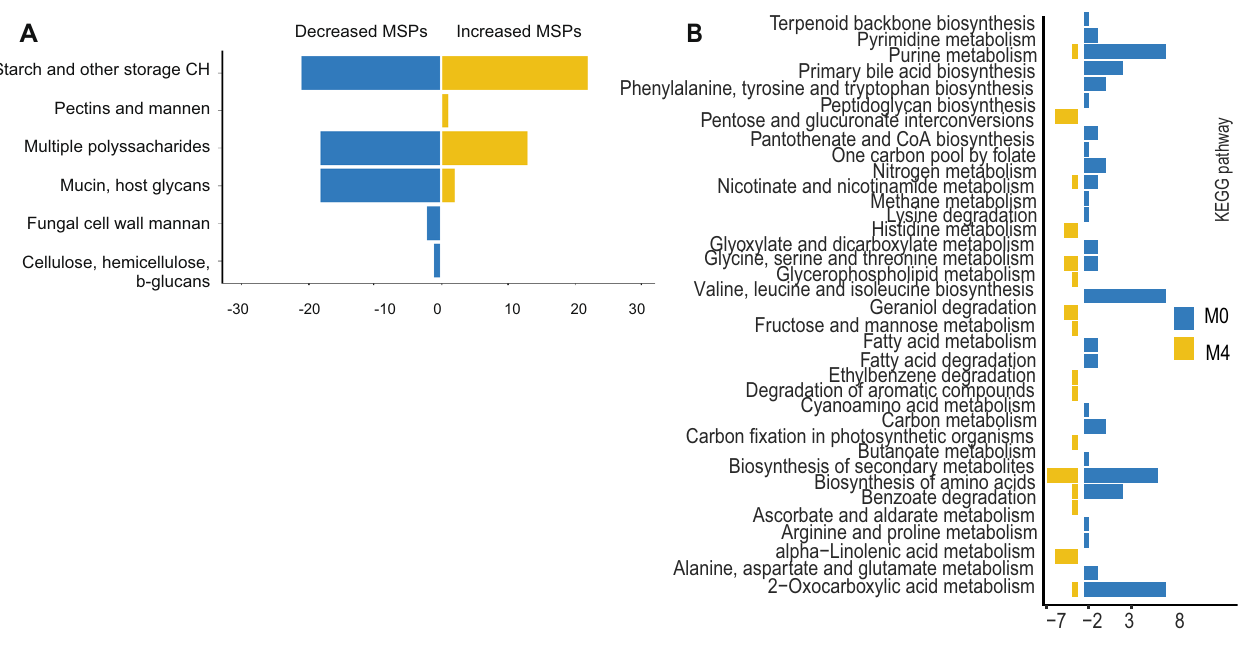
Fig. 2 Functional annotation and reaction abundance pathway enrichment. A Carbohydrate-active enzymes (CAZymes) genes annotation of the top 10 most signi fi cantly increased and decreased species after metformin treatment (Wilcoxon signed-rank test, FDR <0.05). Genes annotated to mucin and host glycans are higher in species that are decreased after metformin treatment. B Signi fi cant metabolic pathway enrichment based on GEMs for MSPs in 22 patients before (M0) and after treatment (M4) (Wilcoxon signed-rank test, p < table 1). Using MSPs and the gut microbial catalog identi fi ed